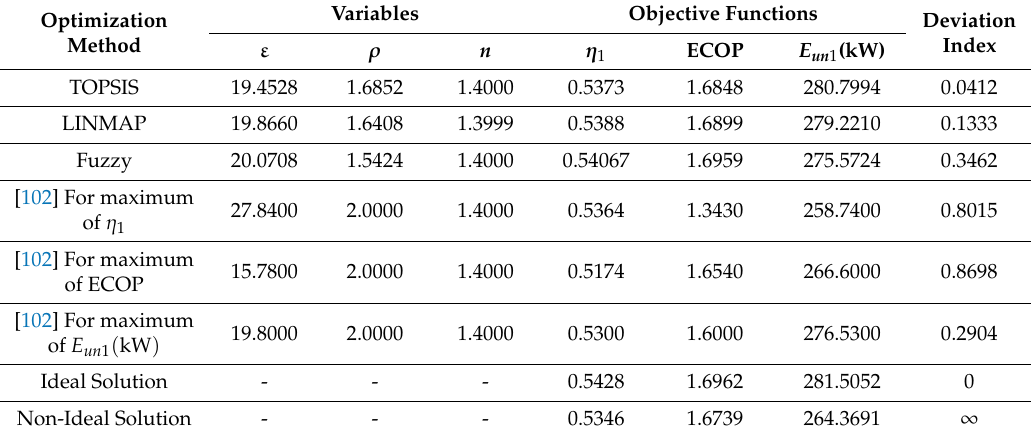
Table 1. Optimization results ( n < k ).